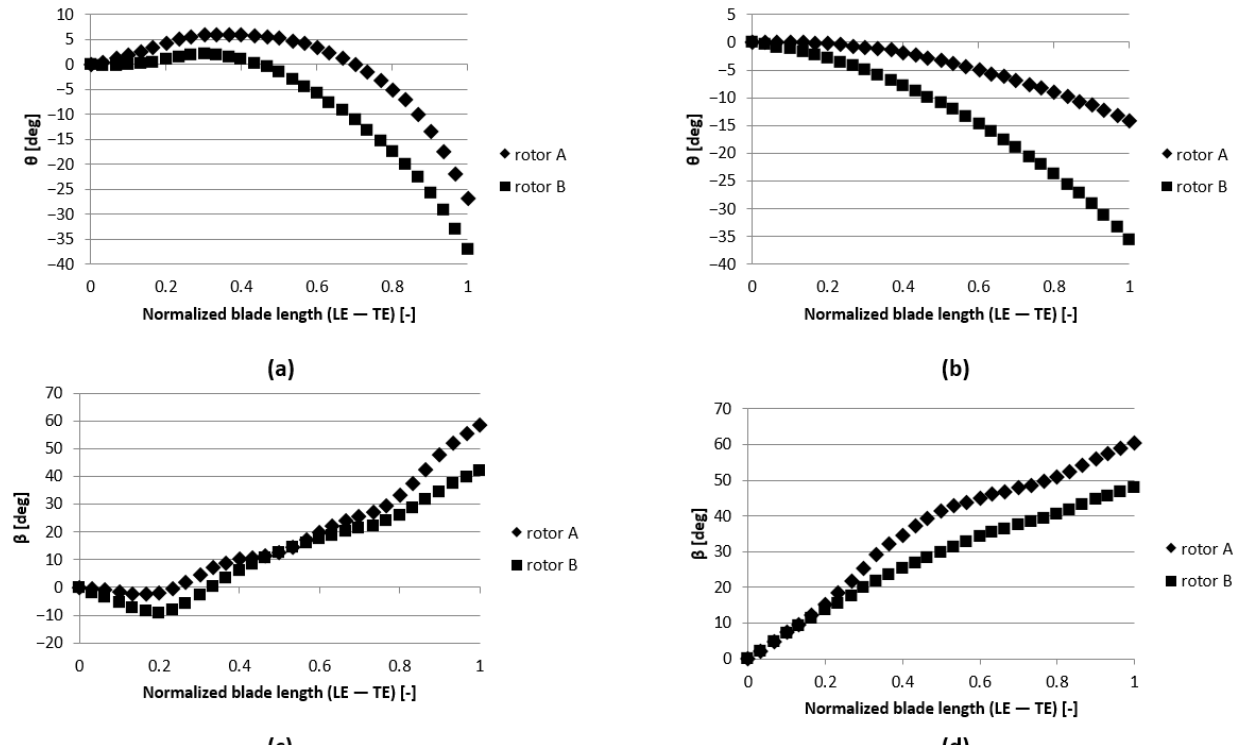
Figure 3. Angular comparison of rotors A and B: ( a ) theta angle at hub, ( b ) theta angle at shroud, ( c ) beta angle at hub and ( d ) beta angle at